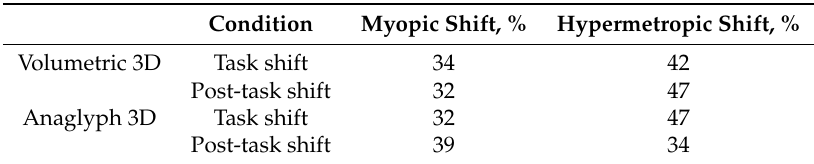
Table 2. Refraction shift type distribution in two participant groups (Volumetric 3D and Anaglyph 3D) during sessions (task shift) and after sessions (post-task shift). Condition Myopic Shift,